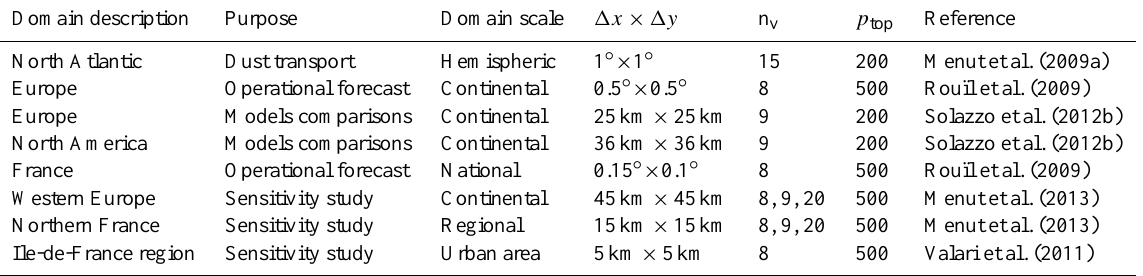
Table 2. Landuse categories used in CHIMERE